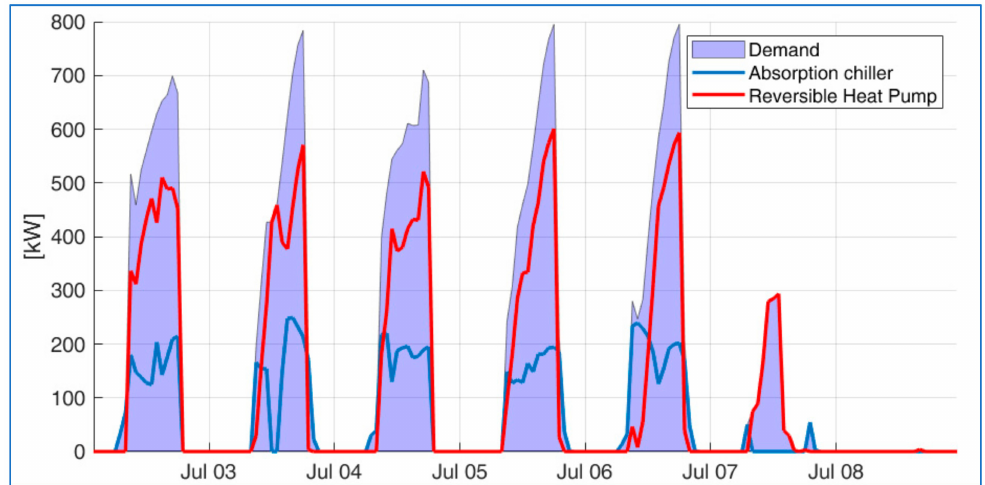
Figure 11. Optimal operation: cooling demand and load shares in a typical